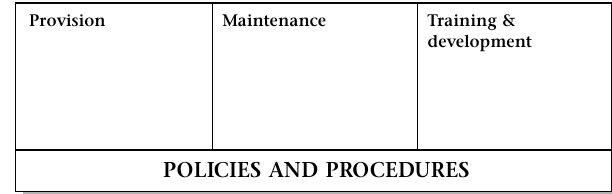
Figure 1: Human Resource function in